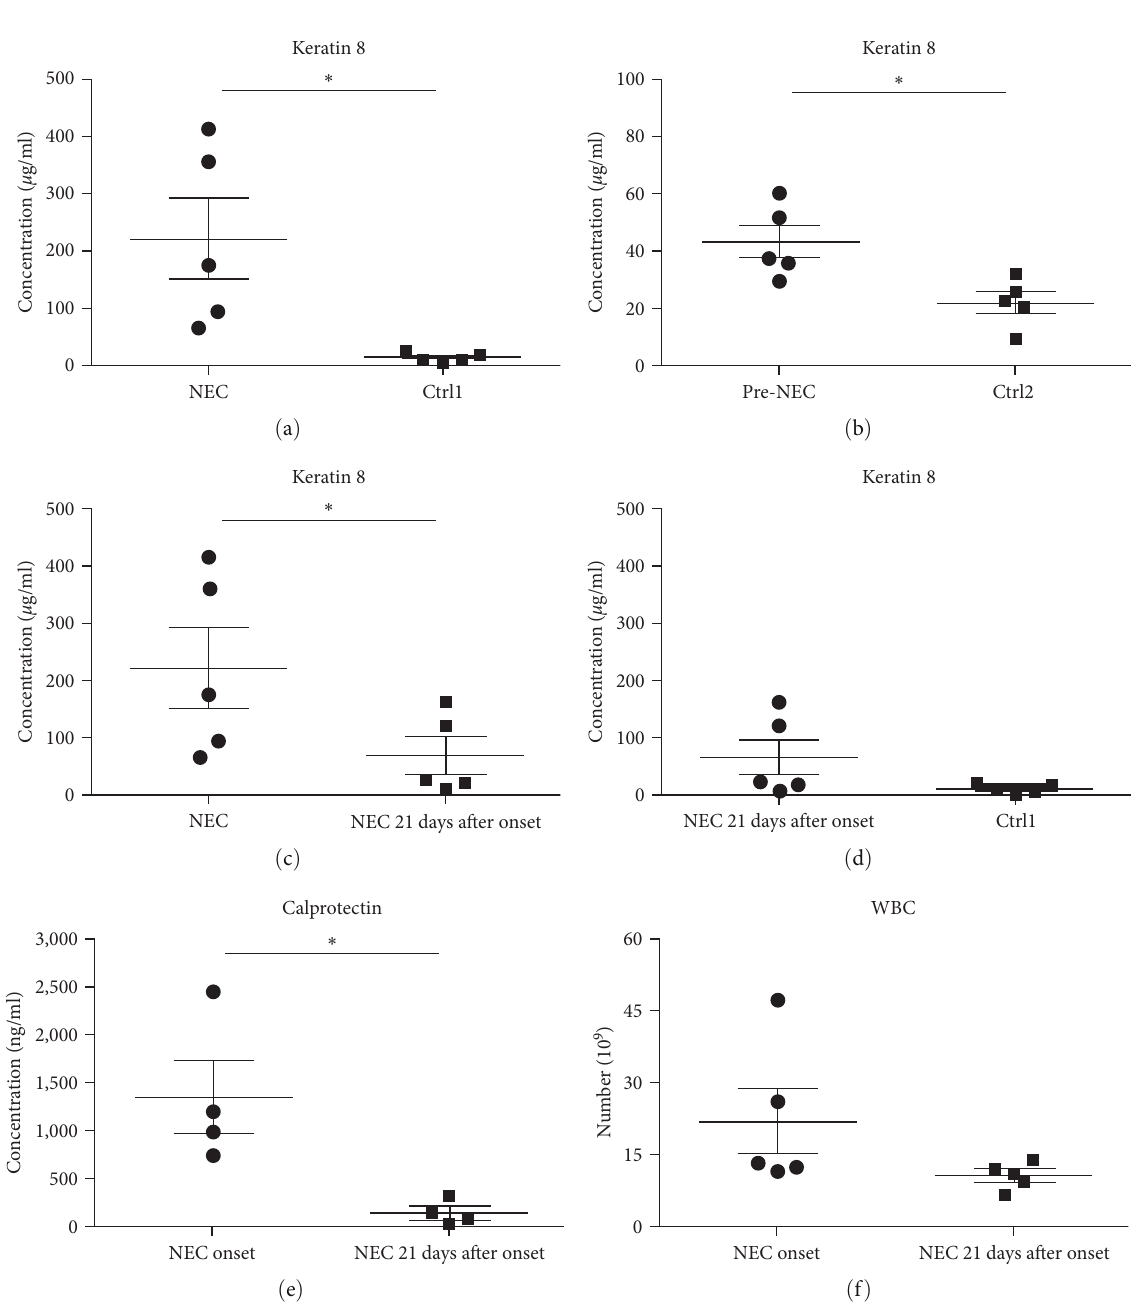
F IGURE 2: Fecal K8 levels in NEC- and GA-matched non-NEC premature neonates: (a) fecal K8 levels of neonates at initial NEC onset (i.e., when NEC was diagnosed) vs. their levels in GA-matched control group (Ctrl1) (mean Æ SEM) ( n = 5); (b) fecal K8 levels of neonates at 1 – 2 days before NEC were diagnosed (pre-NEC) vs. levels in GA-matched control group (Ctrl2) ( n = 5). Note that the fecal K8 was increased ∼ 2 days before a clinical diagnosis, suggesting that it may become a useful biomarker for early diagnosis of NEC; (c) fecal K8 levels of neonates at initial NEC onset vs. levels at 21 days after NEC onset ( n = 5); (d) fecal K8 levels of neonates at 21 days after NEC onset vs. levels in GA- matched control group (Ctrl1) ( n = 5); fecal calprotectin (e) ( n = 4) and WBC (f) ( n = 5) at initial NEC onset vs. levels at 21 days after NEC onset. WBC, white blood cell. ∗ p < 0 :